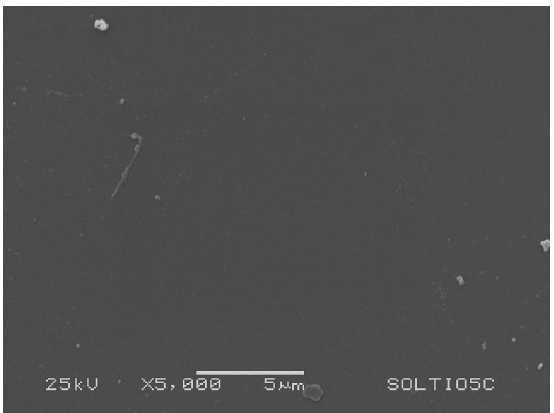
compact layer overlying conductive glass, and ( b ) second Figure 5. SEM images ( a ) TiO 2 nanoporous TiO layer formed by screen-printing 2